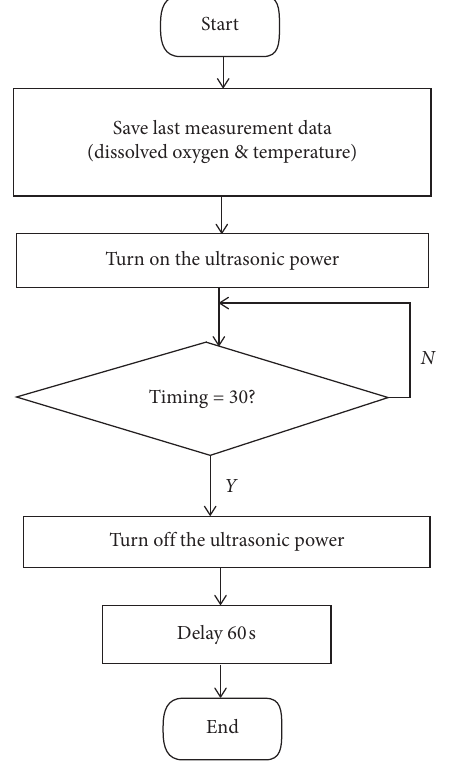
Figure 4: The self-cleaning and self-adaption.